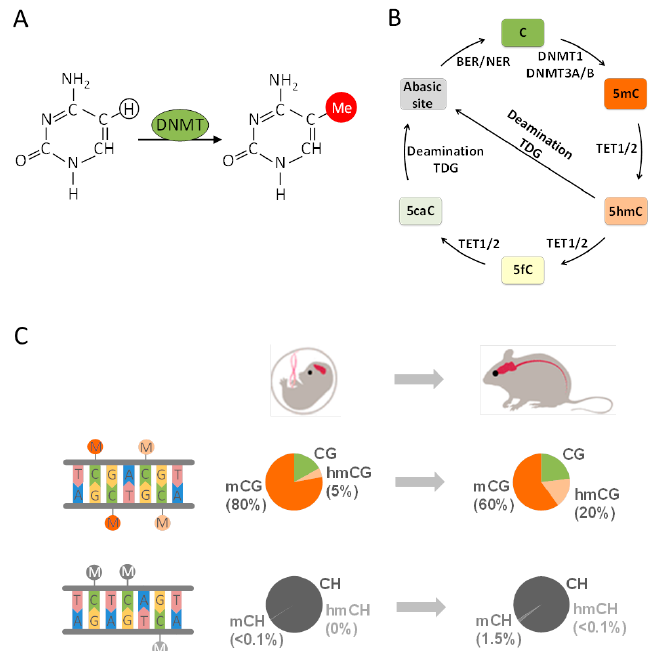
Figure 1. The life-cycle and distribution of DNA methylation in mammalian cells. ( A ) The nucleotide cytosine ( C ) is methylated at the 5th carbon either by de novo DNA methyltransferases DNMT3A or DNMT3B or by the DNA maintenance methyltransferase 1 (DNMT1) during DNA replication; ( B ) active demethylation of 5-methylcytosine (5mC) takes place through iterative oxidation by ten-eleven translocation proteins (TET1/2), producing 5-hydroxymethylcytosine (5hmC). This product is further oxidized to 5-formylcytosine (5fC) and lastly 5-carboxylcytosine (5caC). By an alternative route, 5caC, but also 5hmC, are deaminated to thymine and excised by thymine DNA glycosylase (TDG). Lastly, the mismatched bases are repaired by the base excision and/or nucleotide excision repair machinery (BER/NER); ( C ) cortical methylomes in fetal and adult mice. CpG methylation and non-CpG methylation are shown. Methylcytosine and hydroxymethylcytosine at CG dinucleotides are symbolized by dark and light orange lollipops, respectively. The diagrams display the percentage of unmethylated (CG or CH), methylated (mCG or mCH), and hydroxymethylated (hmCG or hmCH) cytosines. The amount of hydroxymethylcytosine rises with age at the expense of methylcytosine, indicative of a ten-eleven translocation enzyme catalyzed conversion of methylcytosine into hydroxymethylcytosine; mCH is weakly present at fetal stages but strongly rises during mice development.